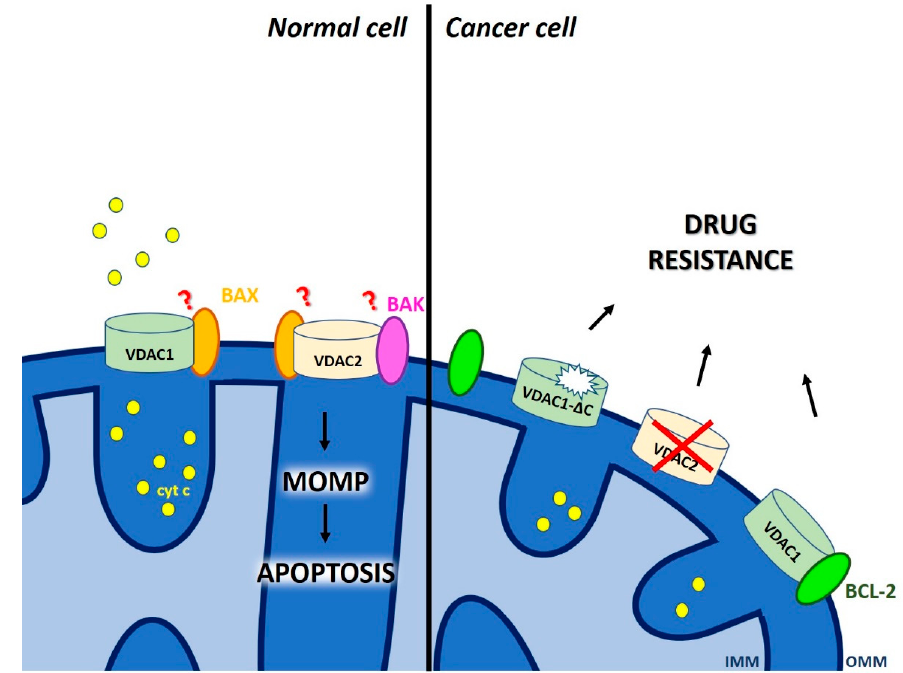
Figure 4. The role of voltage-dependent anion channels in outer membrane permeabilization and in development of chemo-resistance. In healthy cells, VDAC1 oligomerization may lead to MOMP either by homo-oligomerization or by interaction with BAX. Interaction of BAK and BAX with VDAC2 isoform also contributes to MOMP. Instead, expression of a truncated form of VDAC1, association of VDAC1 with anti-apoptotic BCL-2 protein or downregulation of VDAC2 expression contribute to chemo-resistance in cancer cells. See text for further details.